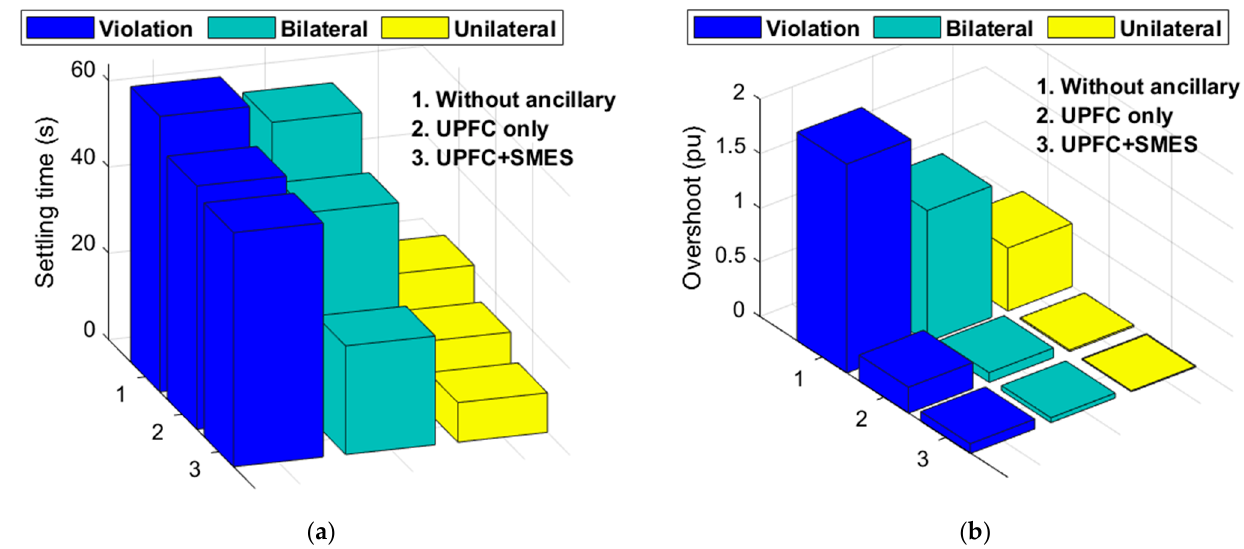
Figure 15. Transient performance of tie-line power deviations under unilateral, bilateral, and contract violation scenarios: ( a ) tie-line power change (settling time); ( b ) tie-line power change (overshoot).